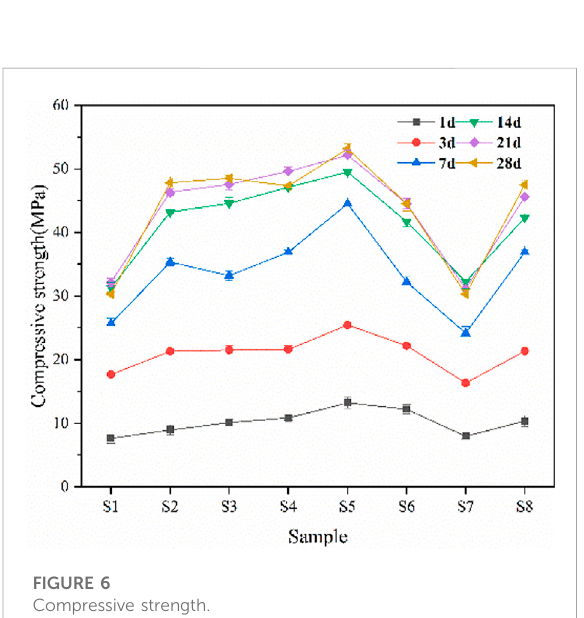
Flexural strength.